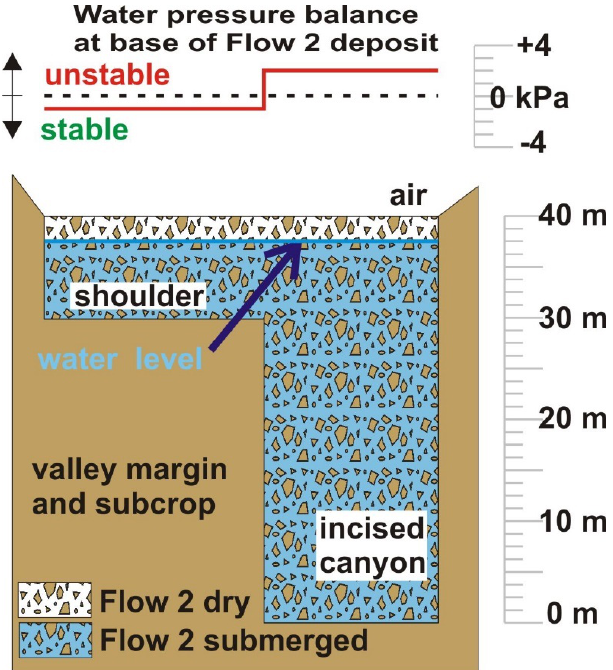
Figure 11. A simplified scenario to portray the uneven distribution of hydrostatic pressure along the base of Flow 2 deposits, due to the pre-existence of the incised canyon. The pressure balance between the dam and water is shown by the upper curve (arbitrary density for the snow avalanche dam of 0.9 g/cm 3 was used), showing that the dam over the shoulder is stable, while along the incised canyon the situation is inverse, that dam section would have been floated before reaching the portrayed scenario.